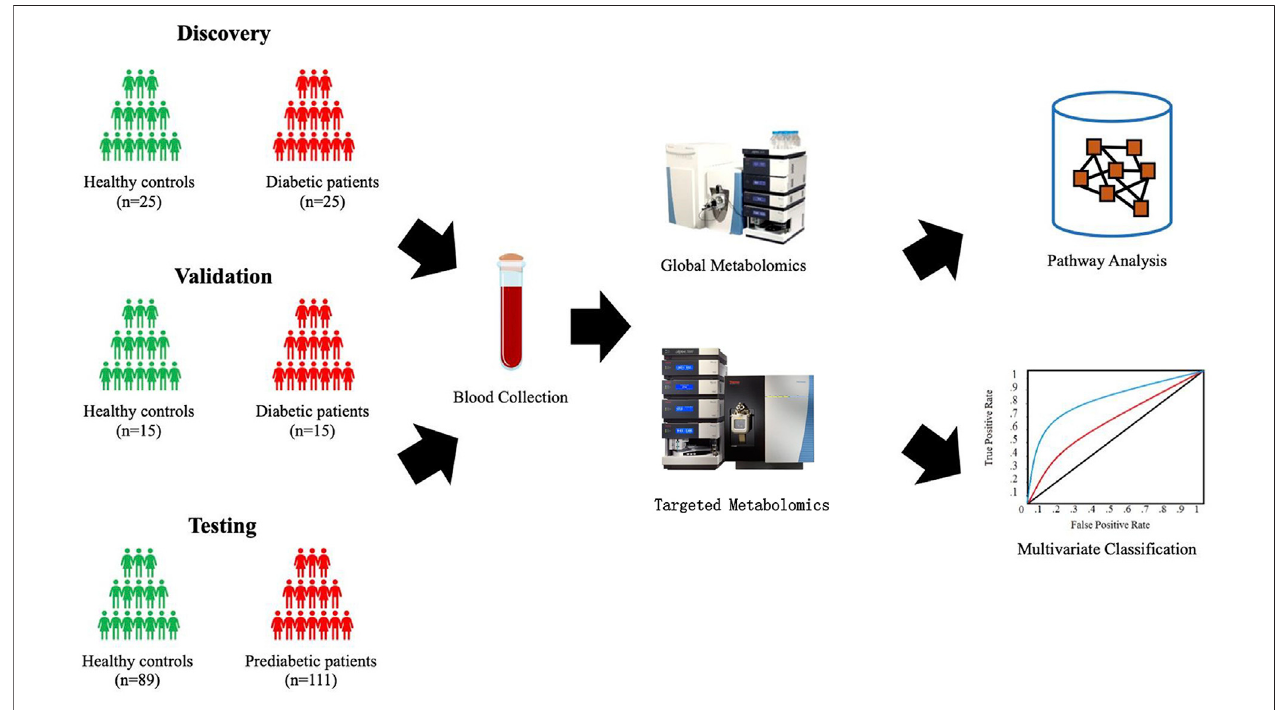
FIGURE 1 | Schematic study design.